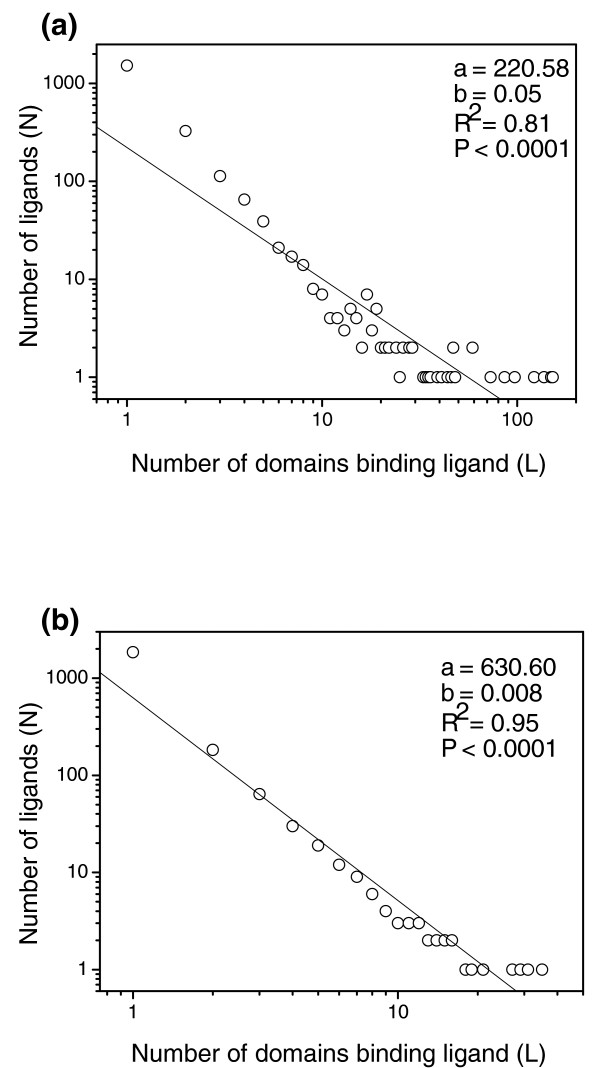
Power-law behaviors of ligand-protein binding. The number of ligands (N) decays with an increase in the number (L) of (a) domains and (b) folds that bind the ligand and follows the equation N = aL-b. The figure illustrates that a few ligands cover tens of protein domains or folds, while most ligands bind only one domain or fold.